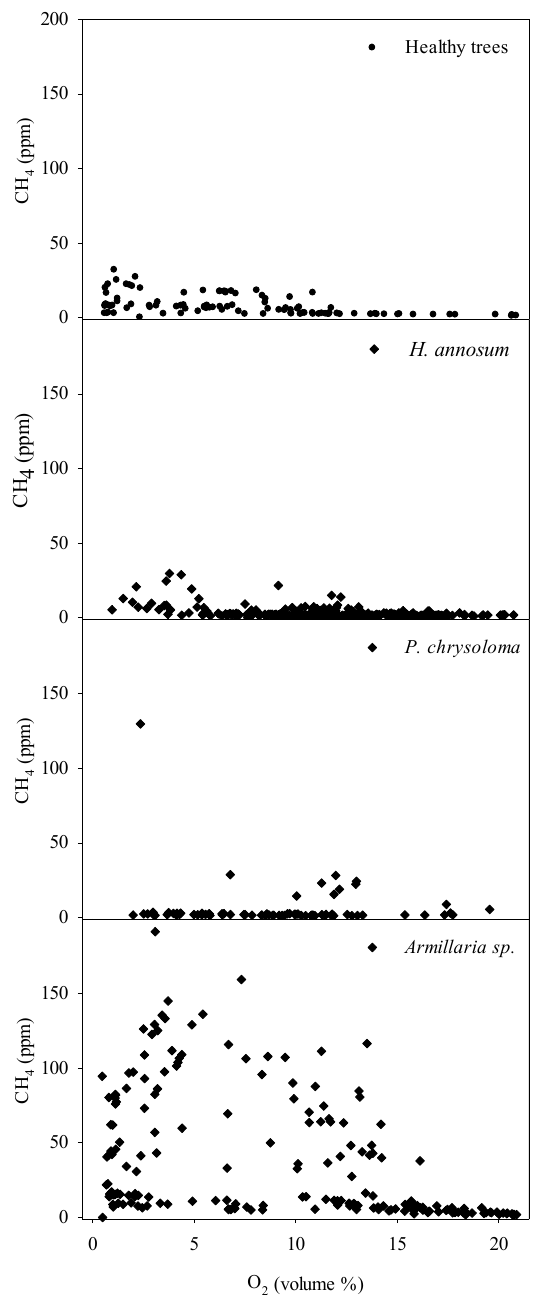
Figure 2. The relationship between in situ concentrations of CH 4 and O 2 within healthy stems of Norway spruce and stems with heartwood decay caused by Heterobasidion annosum s.l., Phellinus chrysoloma and Armillaria spp . The dataset involves thirtyseven Norway spruce trees from seven sites in South Eastern Norway, and shows values recorded throughout two growing